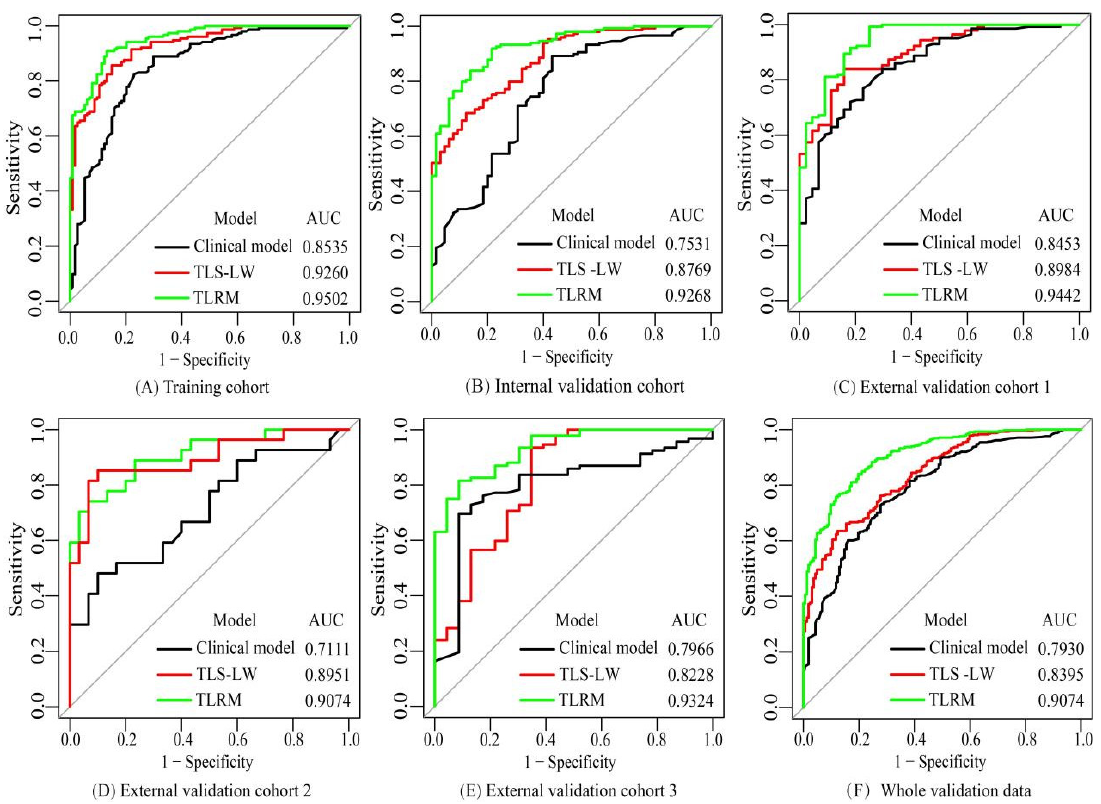
Figure 5. The receiver operating characteristic curves of the clinical model, TLS-LW, and TLRM in the training cohort ( A ), internal validation cohort ( B ), external validation cohort 1 ( C ), external validation cohort 2 ( D ), external validation cohort 3 ( E ) and whole validation data ( F ). Note: TLS-LW, transfer learning signature based on lung cancer WSI; TLRM, transfer learning radiomics model; AUC, area under the